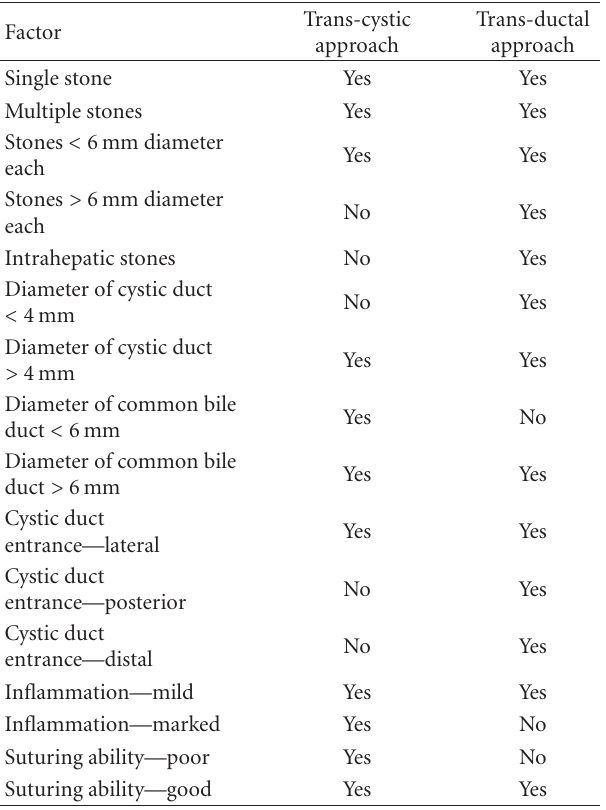
Table 2: E ff ective and important factors in CBD stones approach